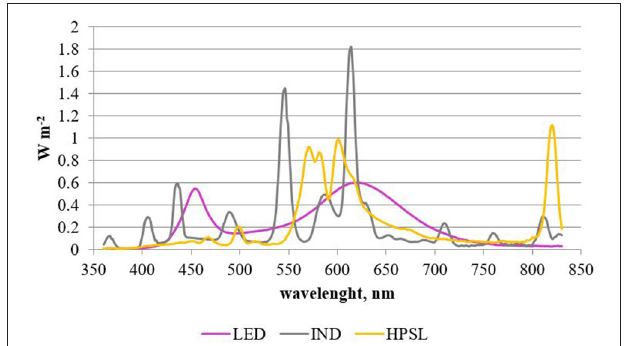
FIGURE 1 | Spectrum of lighting sources.